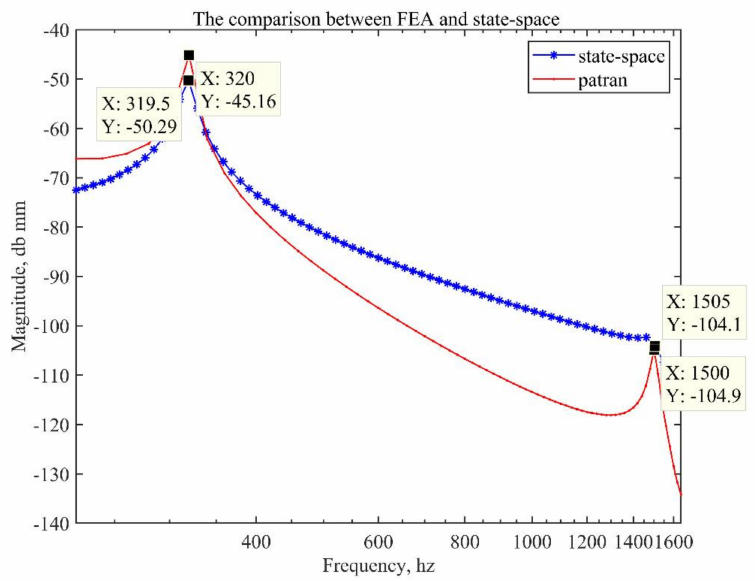
Figure 13. Comparison of finite element analysis (MSC.Patran) and the state space